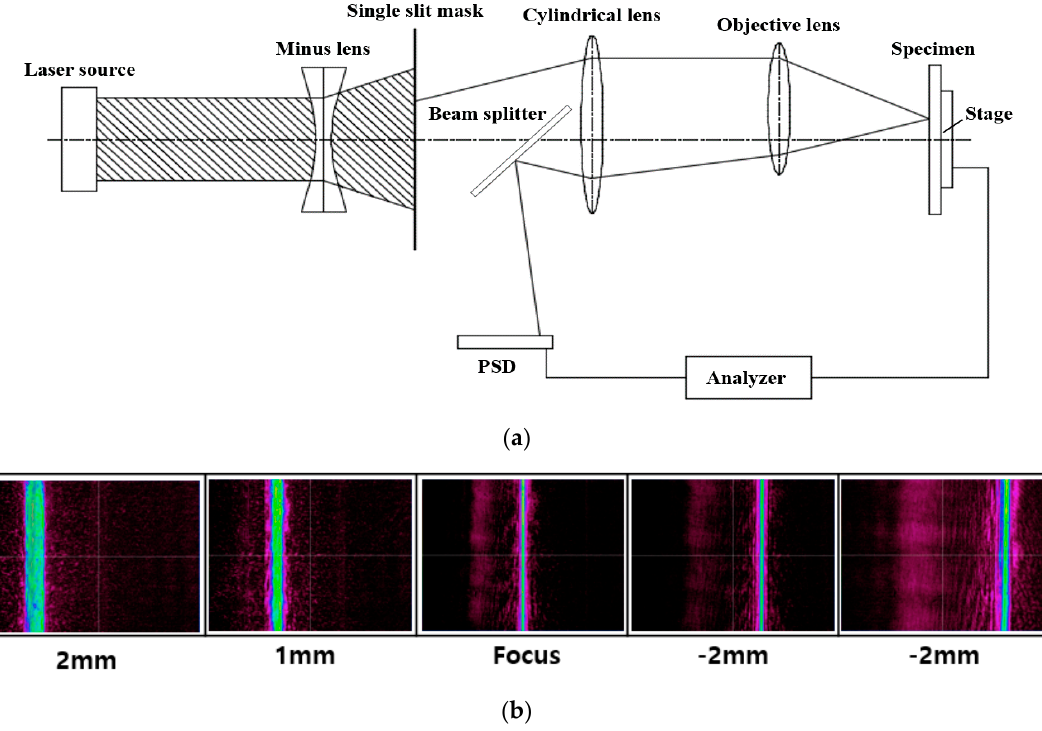
Figure 2. ( a ) Schematic of the optical beam path in the proposed system. ( b ) Variation of the slit image position on the CCD camera when the specimen is positioned at the focus and at different defocus distances.